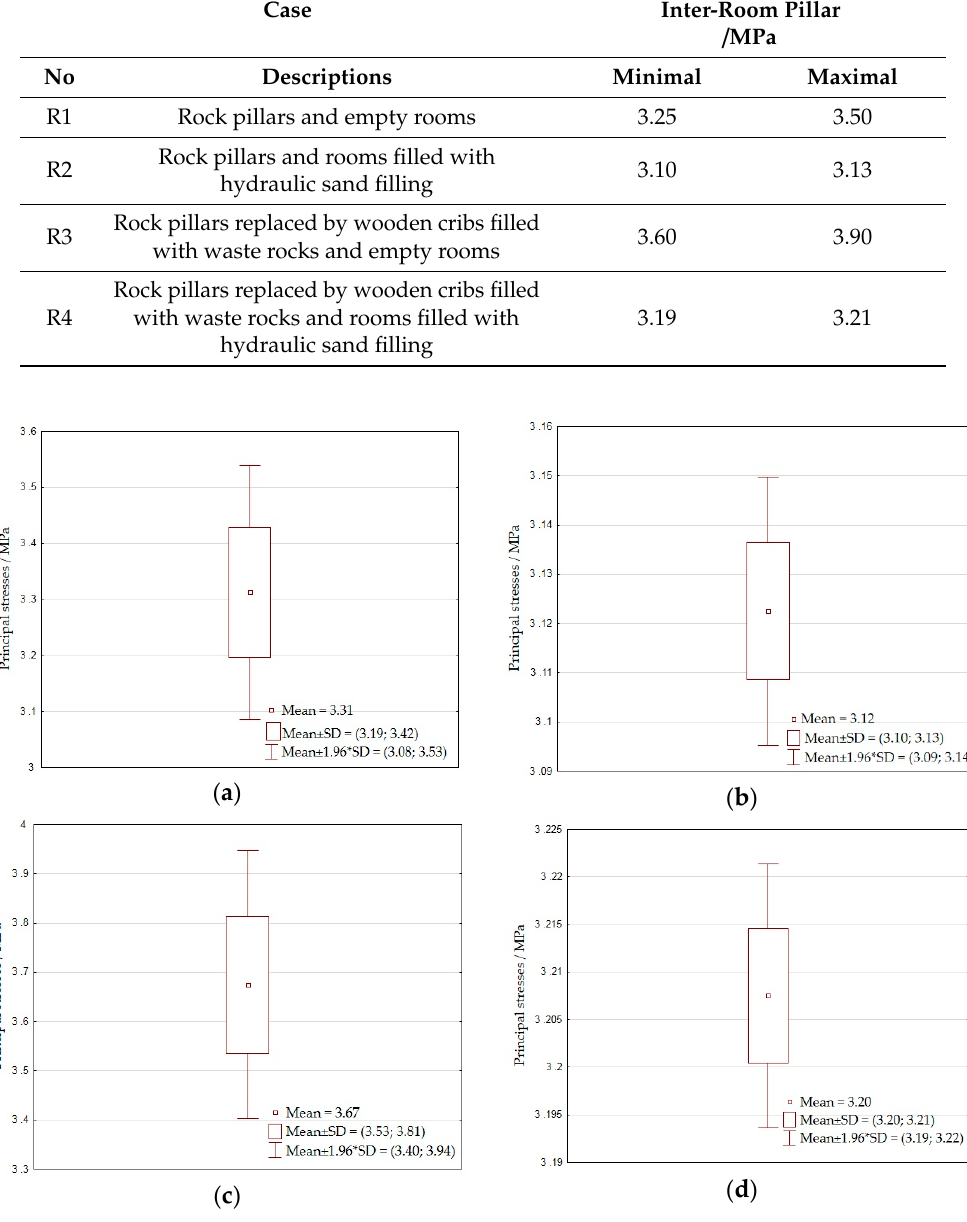
Figure 13. Mean and standard deviation (SD) for principal stresses in relation to the designed room and pillar method: ( a ) Rock pillars and empty rooms (R1); ( b ) Rock pillars and rooms filled with hydraulic sand filling (R2); ( c ) Rock pillars replaced by wooden cribs filled with waste rocks and empty rooms (R3); ( d ) Rock pillars replaced by wooden cribs filled with waste rocks and rooms filled with hydraulic sand filling